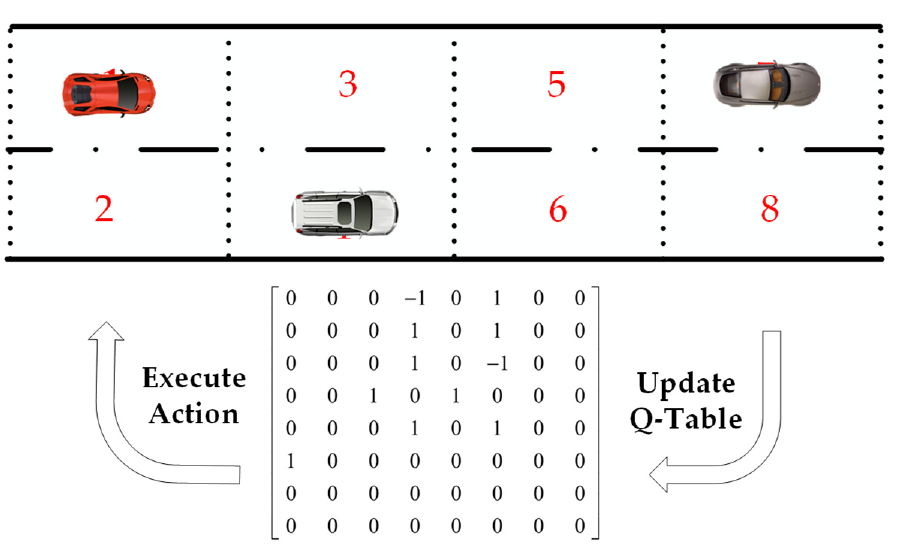
stored in the Q -table, can be selected to obtain the maximum benefit action. The structure of Q-Learning is shown in Figure 5.